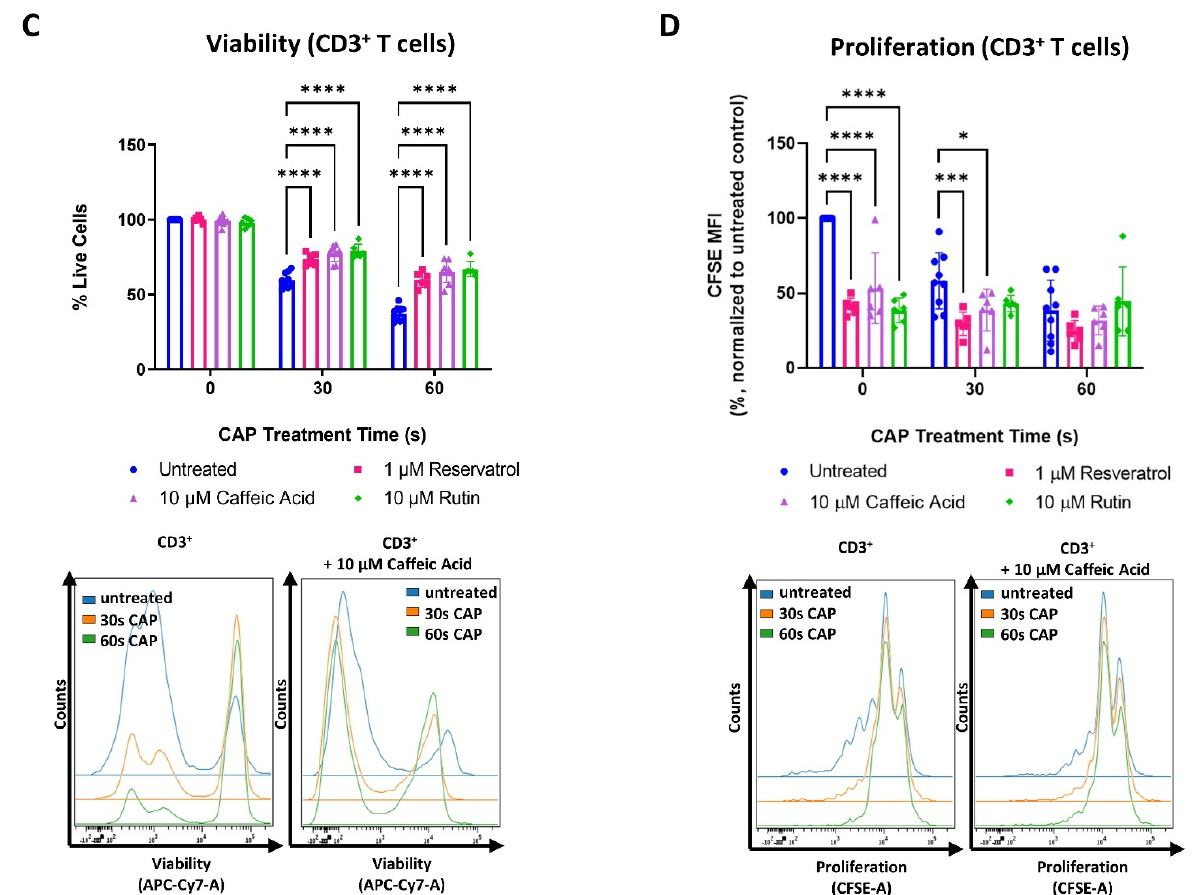
Figure 6. Antioxidant treatment mitigates the effects of CAP on melanoma and CD3 + T cells. ( A , B ) CFSE prelabeled Ma-Mel-19 cells were plated in the presence of various antioxidants and differentially treated with CAP (0 s, 120 s, 180 s). After 3 days, cells were analyzed via flow cytometry; ( A ) Ma-Mel-19 cells were stained for viability. Bar diagram shows the average percentage of live cells measured ± SD and represents the pooled results of 3 independent experiments ( n = 12/untreated, n = 4/antioxidant); ( B ) bar diagram shows the average CFSE mean fluorescent intensity (MFI) mea- sured, normalized to the untreated control ± SD and represents the pooled results of 3 independent experiments ( n = 12/untreated, n = 4/antioxidant); ( C , D ) CFSE prelabeled stimulated CD3 + T cells were plated in the presence of various antioxidants, and differentially treated with CAP (0 s, 30 s, 60 s). After 3 days, cells were analyzed via flow cytometry; ( C ) CD3 + T cells were stained for viability. Bar diagram shows the average percentage of live cells measured ± SD and represents the pooled results from 3 independent experiments (total replicate size: n = 9/untreated, n = 6/antioxidant); ( D ) bar diagram shows the average percentage of proliferating CD3 + T cells normalized to the untreated control from the same donor ( n = 9/untreated, n = 6/antioxidant) ± SD and represents the pooled results from 3 independent experiments; histograms paired to bar diagrams show one representative result. Statistical significance was calculated by performing two-way ANOVAs corrected for multiple comparisons with Dunnett tests and is indicated by the asterisks as follows: * p < 0.05; *** p < 0.001; **** p <